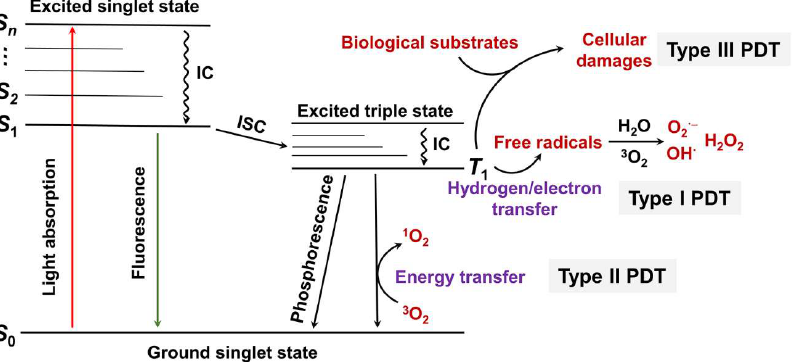
Figure 1. Jablonski’s diagram for the principle of type I, type II, and type III PDT. S 0 : the singlet ground state; S 1 : the first excited singlet state; S 2 : the second excited singlet state; S n : the n th excited singlet state; IC: internal conversion; ISC: intersystem